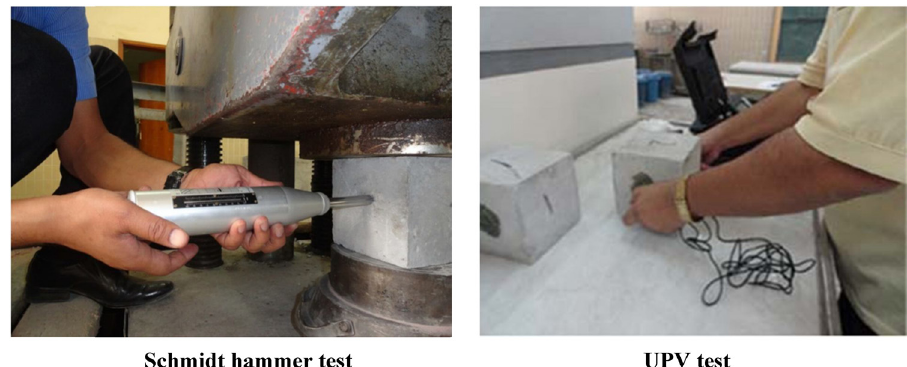
Figure 4: Nondestructive tests.